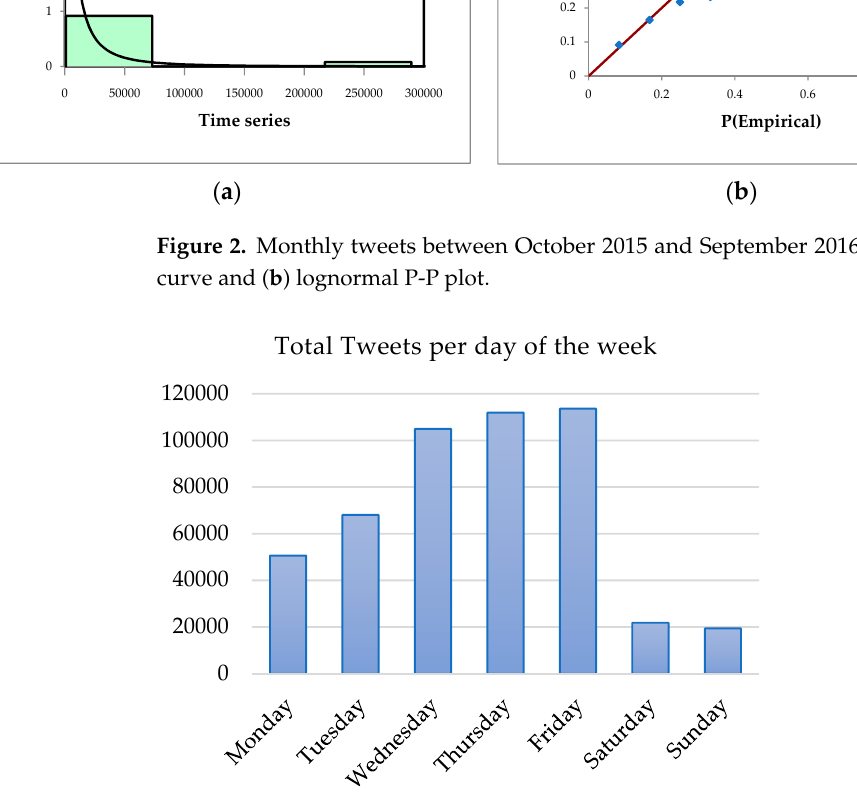
Figure 4. The top ten Twitter users with the highest number of twitter posts, as well as the number of hashtags, URLs, and retweets.